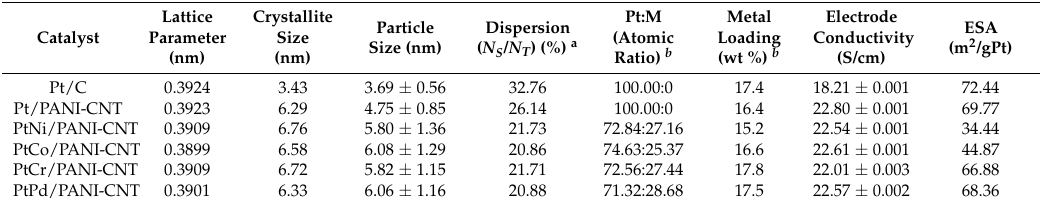
Table 1. Properties of the Pt/C and prepared PtM